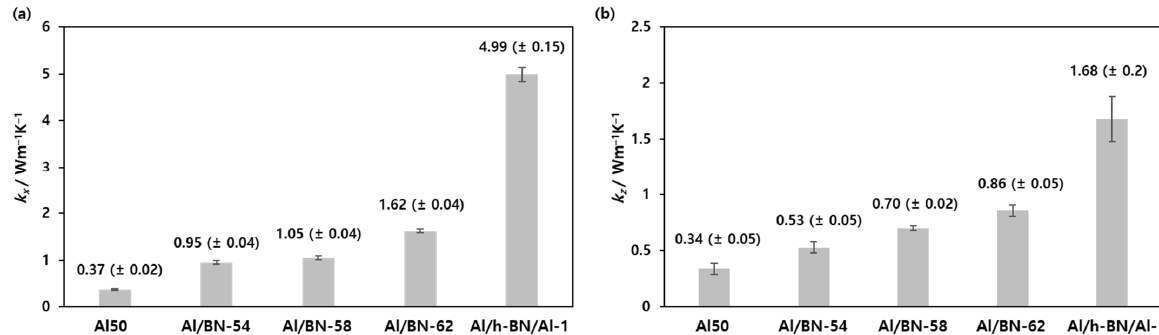
Figure 3. ( a ) k x and ( b ) k z of the Al50, Al/BN, and Al/h-BN/Al-1 composites. Because the viscosity of the composites increased drastically with increasing h-BN content, it is challenging to produce Al/BN composites with >62 wt.% fillers through conventional methods. To address this issue, Al/h-BN/Al composites were fabricated through a sequential coating process in this study. Because a solution of h-BN was coated onto a silicone-based Al 2 O 3 composite layer through a metal mask and laminated with another silicone-based Al 2 O 3 composite by hot pressing (Figure 1), this fabrication method could be used to circumvent the use of highly viscous Al 2 O 3 /h-BN composites to attain high thermal conductivity [24]. To fabricate a Al 2 O 3 composite layer that would be used as a substrate for h-BN patterns, three types of composites with 80 wt.% Al 2 O 3 (Al80), 85 wt.% Al 2 O 3 (Al85), and 90 wt.% Al 2 O 3 (Al90) were prepared. Their thixotropic